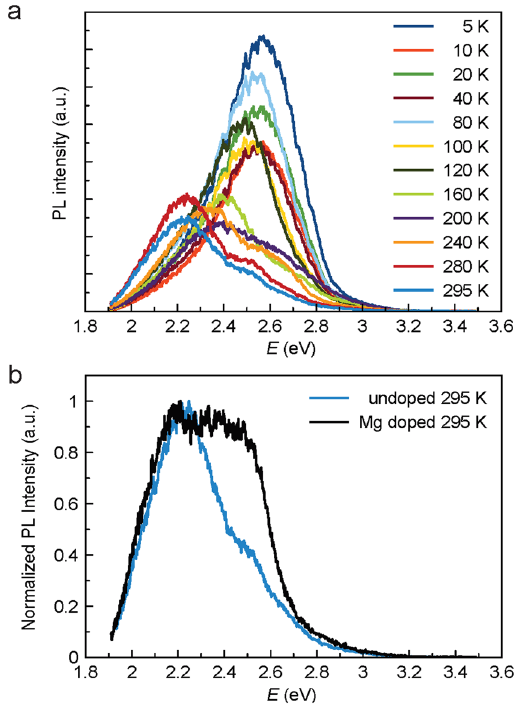
Figure 5. Photoluminescence spectra of GaP films. ( a ) temperature dependent photoluminescence spectra of an undoped, substrate removed GaP film, showing the primary peak at the indirect bandgap at room temperature and a shift towards the secondary gap at lower temperatures. ( b ) in the Mg doped sample, the peak at the indirect bandgap broadens and shifts, indicating states near the band